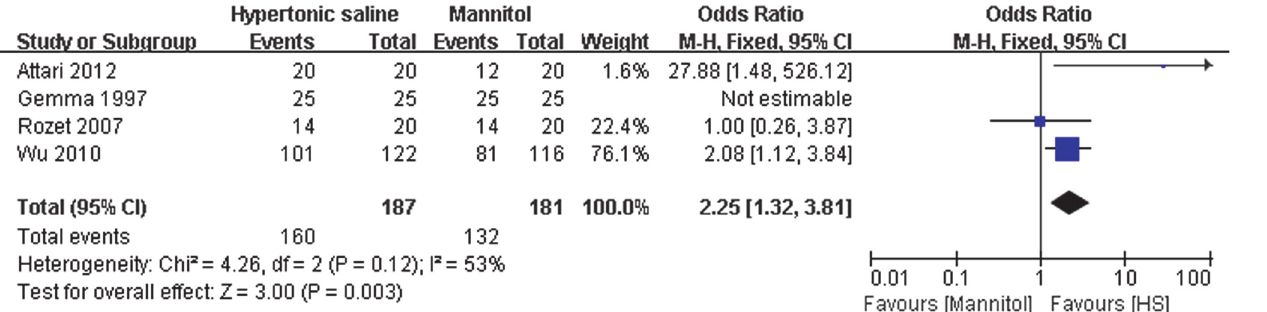
Fig 2. Satisfactory intraoperative brain relaxation in HS and mannitol groups. M-H: Mantel-Haenszel.